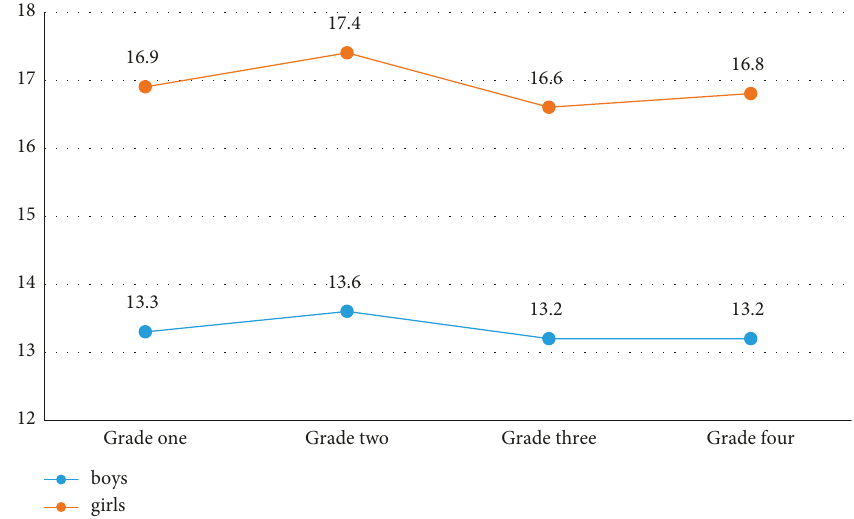
Figure 3: The result change curve of trunk forward bending between boys and girls. Table 8: Girls’ 800-meter race scores and grade ratio.